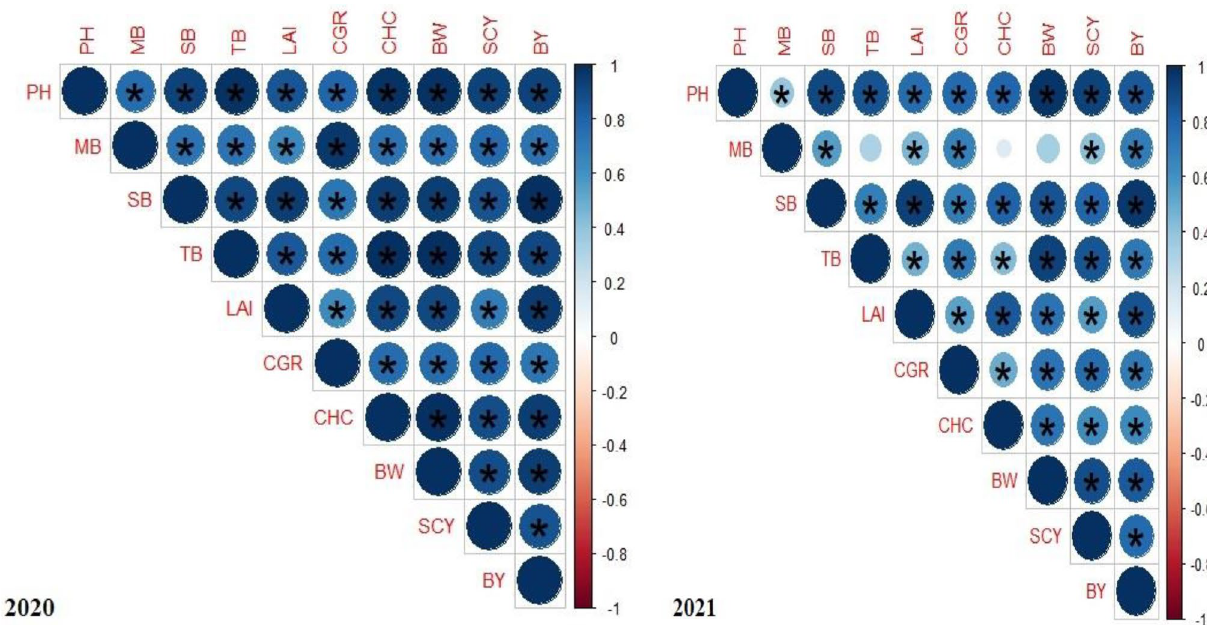
Figure 1. Correlation map showing the effect of different tillage systems, and organic materials on different traits (growth, chlorophyll content, morphological, and yield) of cotton. The areas of circles show the absolute value of corresponding correlation coefficients tested at *0.01 significance level. BY biological yield, SCY seed cotton yield, BW boll weight, CHC chlorophyll content, CGR crop growth rate, LAI peak leaf area index, TB total bolls, SB sympodial branches, MB monopodial branches, PH plant height. *p ≤ 0.05; **≤ 0.01; ***≤